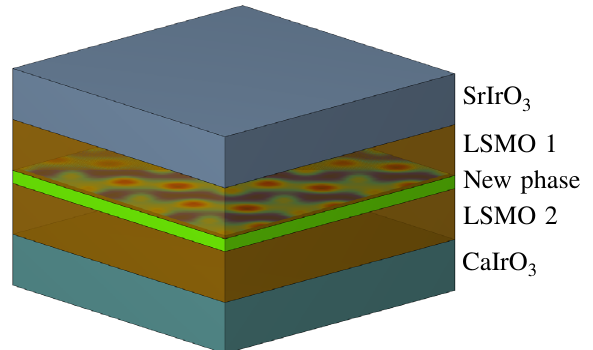
Fig. 1 Schematic illustration of a multilayer to realize “ interfacial phase frustration ” . Shown is a magnetic multilayer, involving different 5 d compounds, top and bottom, and LSMO layers. An emergent phase will appear in the middle layer (green), between two LSMO layers each in fl uenced by two different 5 d compounds with different DMI strengths or different spiral orientations. The central "green'' layer is frustrated by competing tendencies above and